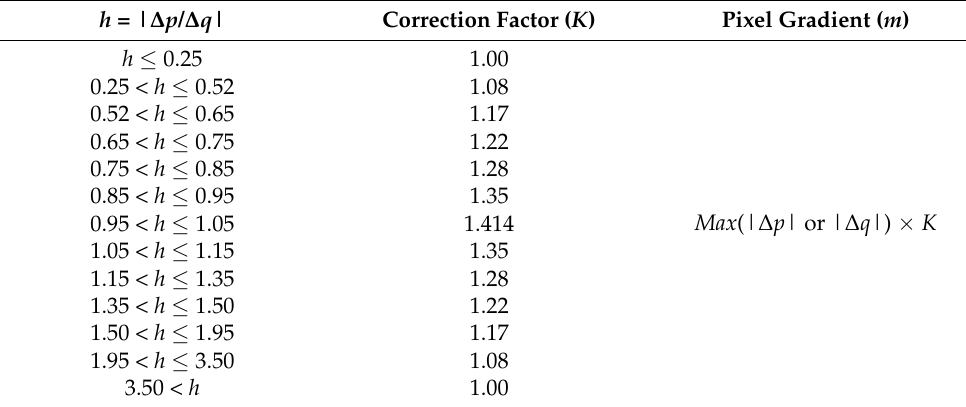
Table 2. Look-up table for gradient correction.